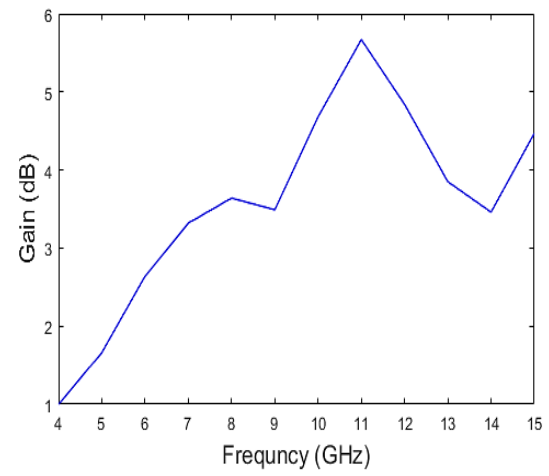
Figure 11: Simulated Gain versus